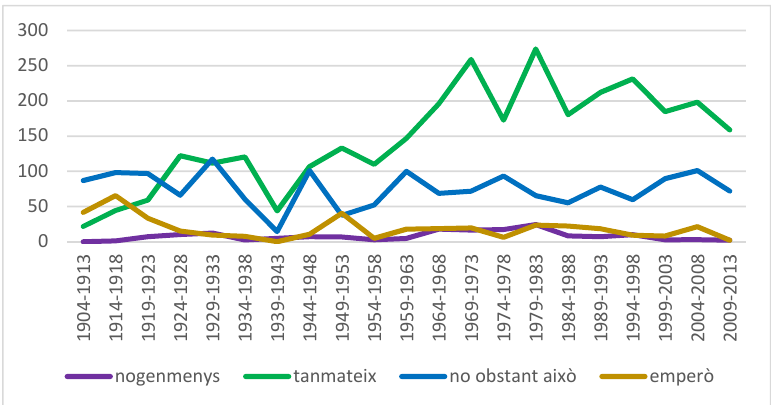
Figure 7. Relative frequency of the four markers analyzed (normalized per 1 million words).